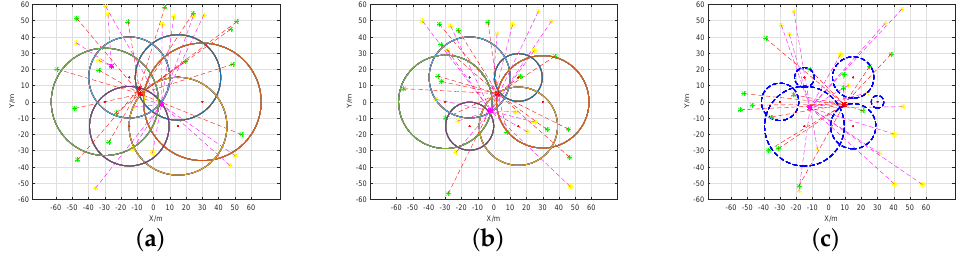
Figure 3. The results of the Gauss–Newton iteration algorithm when different initial values were selected in the cooperative scenario. Above, graph ( a ) shows the result for NLOS positioning environment, graph ( b ) shows the result for LOS environment, and graph ( c ) shows the result when the ranging error was